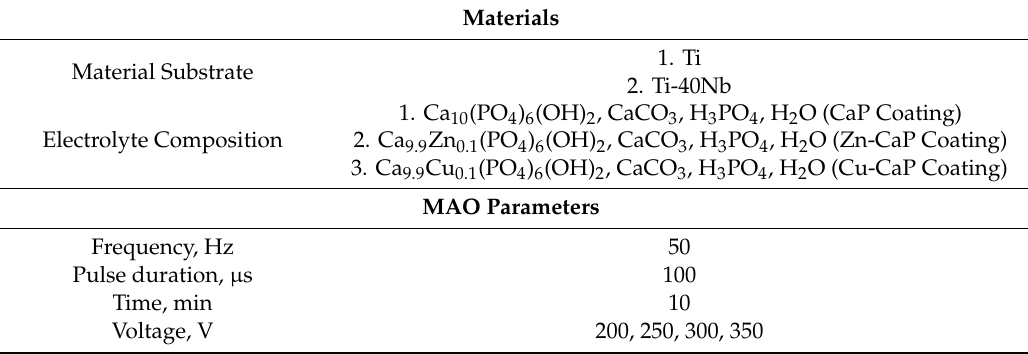
Figure 1. A schematic illustration of the “Micro-Arc 3.0” experimental setup. Table 1. The studied materials and the MAO parameters.